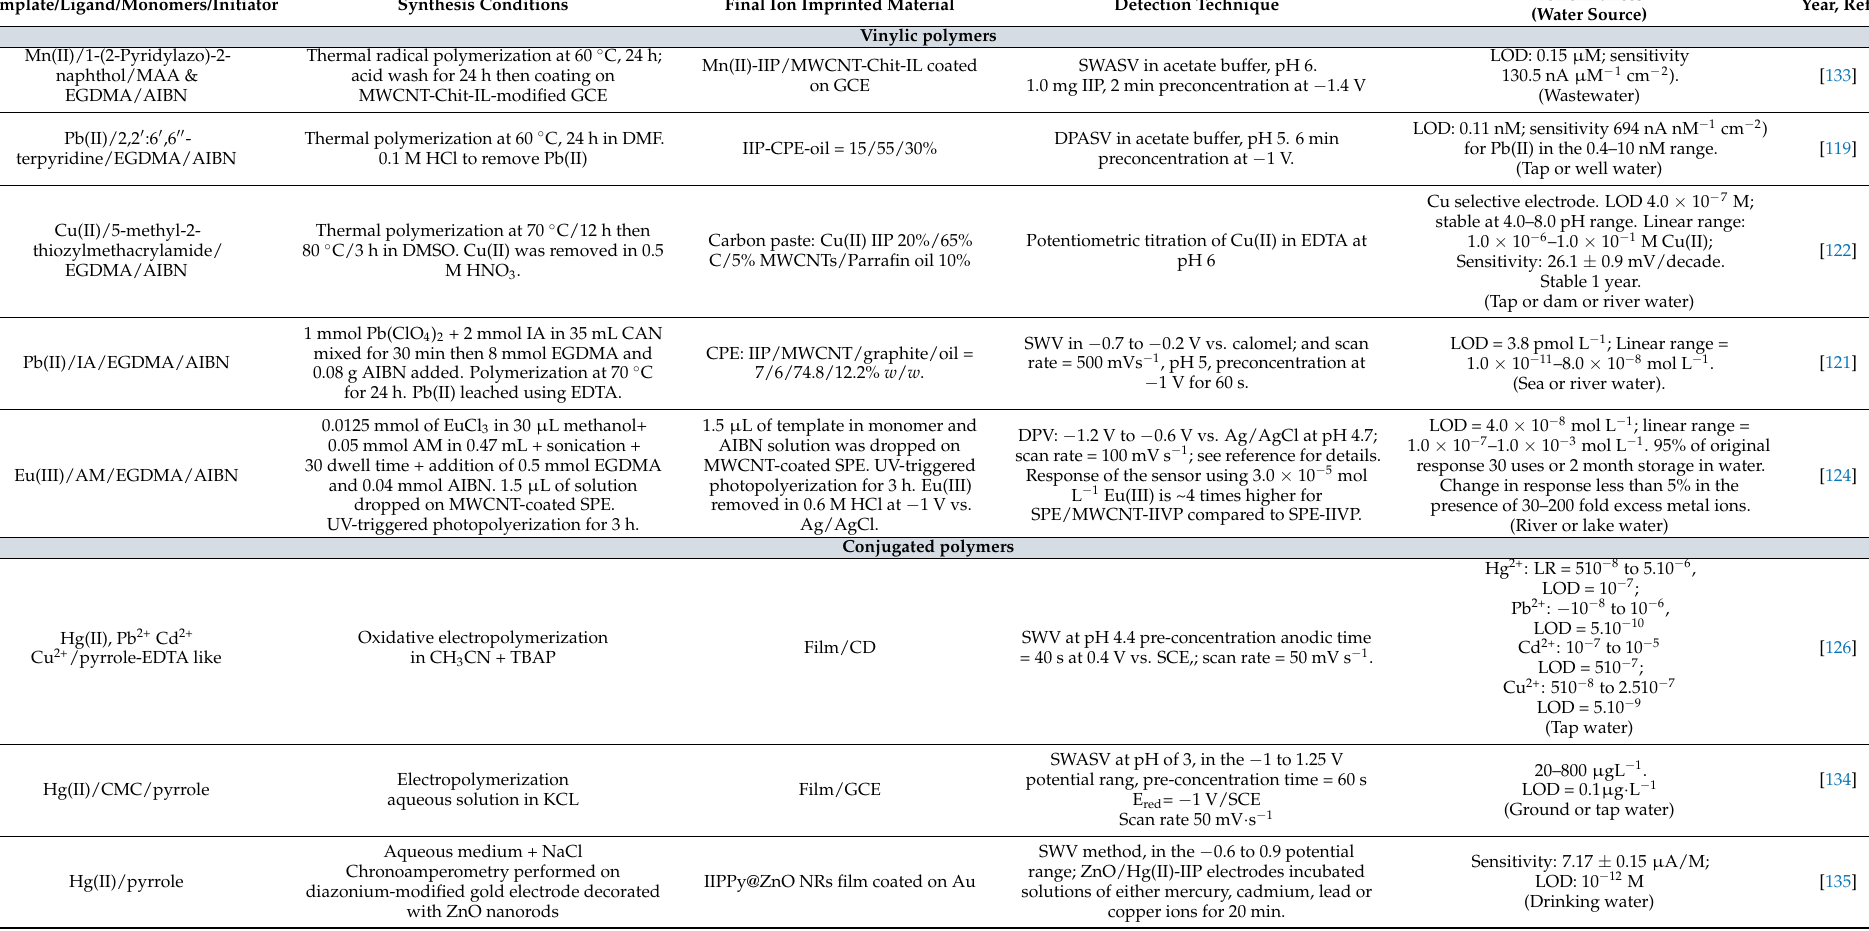
Table 5. Design and performances of selected IIP